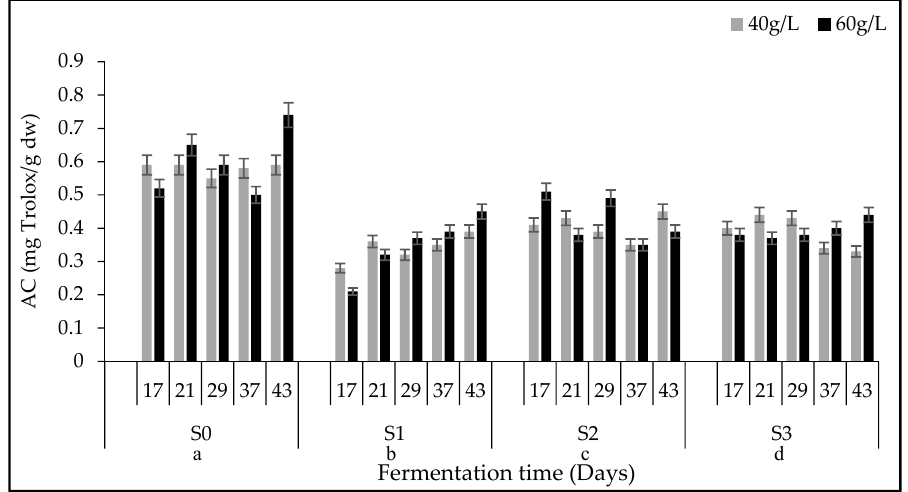
Figure 6. Antioxidant components (AC) produced using DPPH • (mg Trolox/ g dw) during the cultivation of P. pulmonarius in liquid cultures with OMWs containing: (a) 0 g/L phenolic compounds and initial concertation 40 and 60 g/L (S0-G40, S0-G60), (b) 1 g/L phenolic compounds and initial concertation glucose 40 and 60 g/L (S1-G40, S1-G60), (c) 2 g/L phenolic compounds and initial con- certation glucose 40 and 60 g/L (S2-G40, S2-G60), (d) 3 g/L phenolic compounds and initial concer- tation glucose 40 and 60 g/L (S3-G40, S3-G60). Each point is the mean value of at least three inde- pendent measurements, SD < 5%.